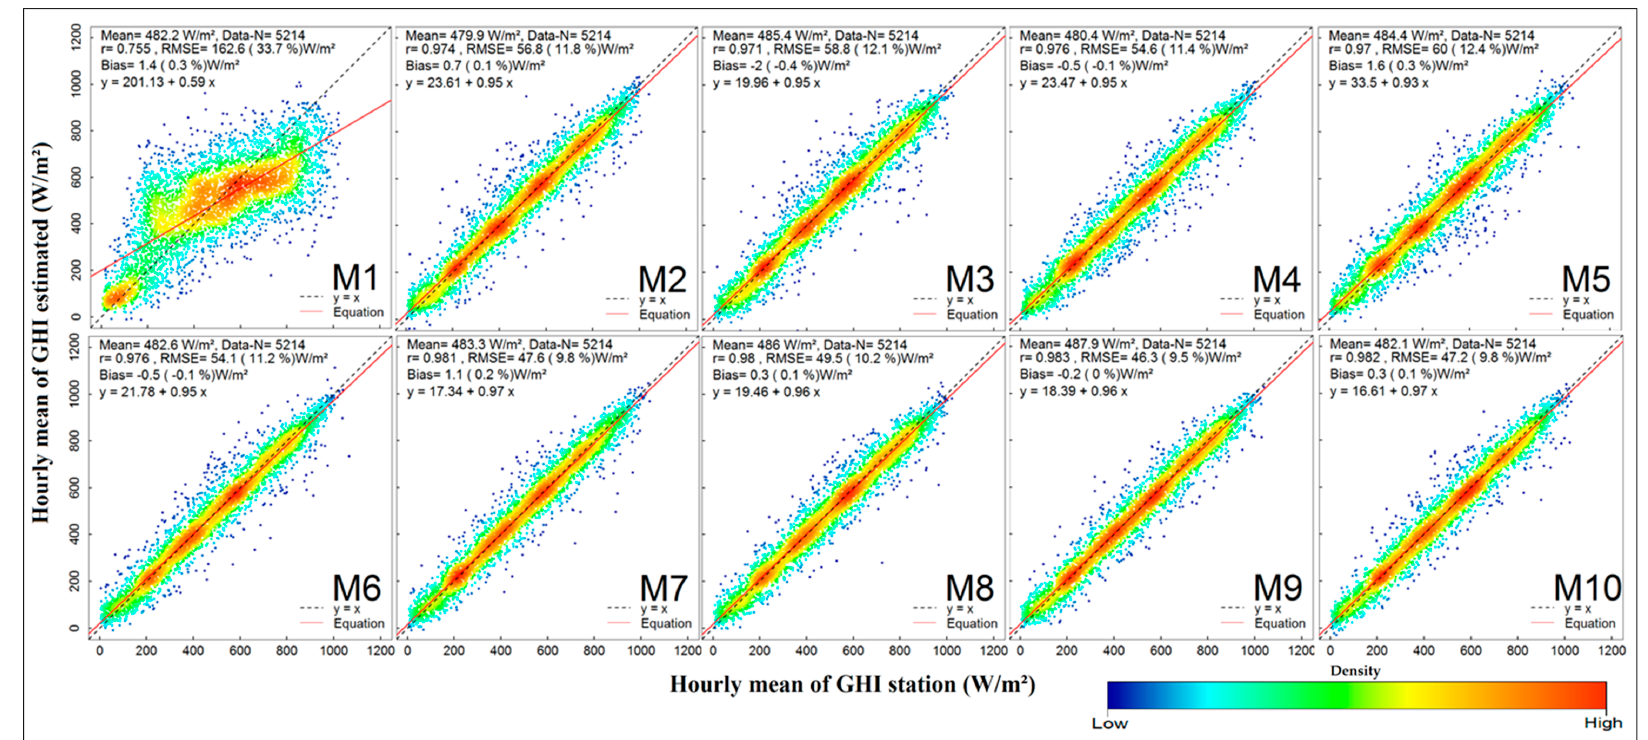
Figure 8. Scatterplots of hourly GHI ground measurements and ANN model estimated from M1–M10 at test data for overall results at automatic stations.